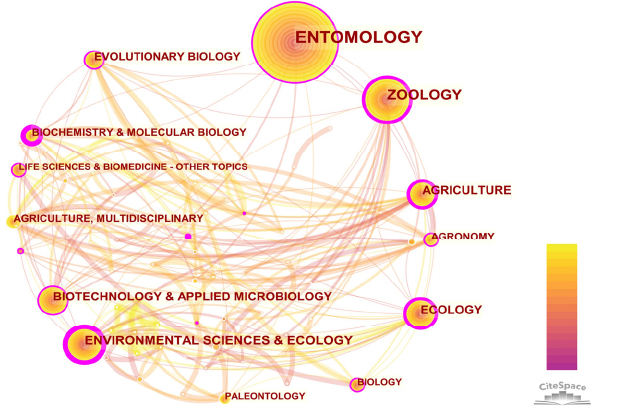
Figure 2. Subject categories co-occurrence network. The node size represents the subject categories’ publication frequency, and the connection line between nodes represents co-occurrence. High-centrality nodes are marked by purple circles.